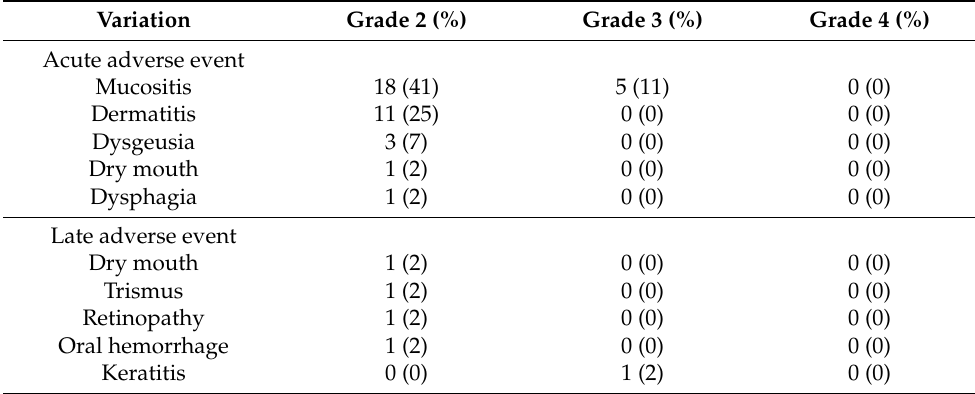
Table 4. Acute and late adverse events for all